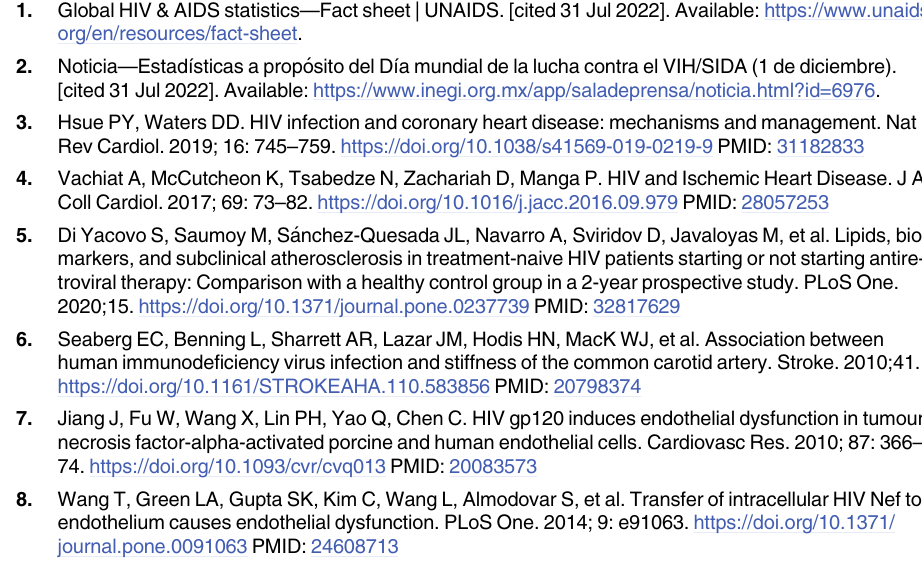
S1 Table. Demographic and clinical characteristics of patients included and not included in the final